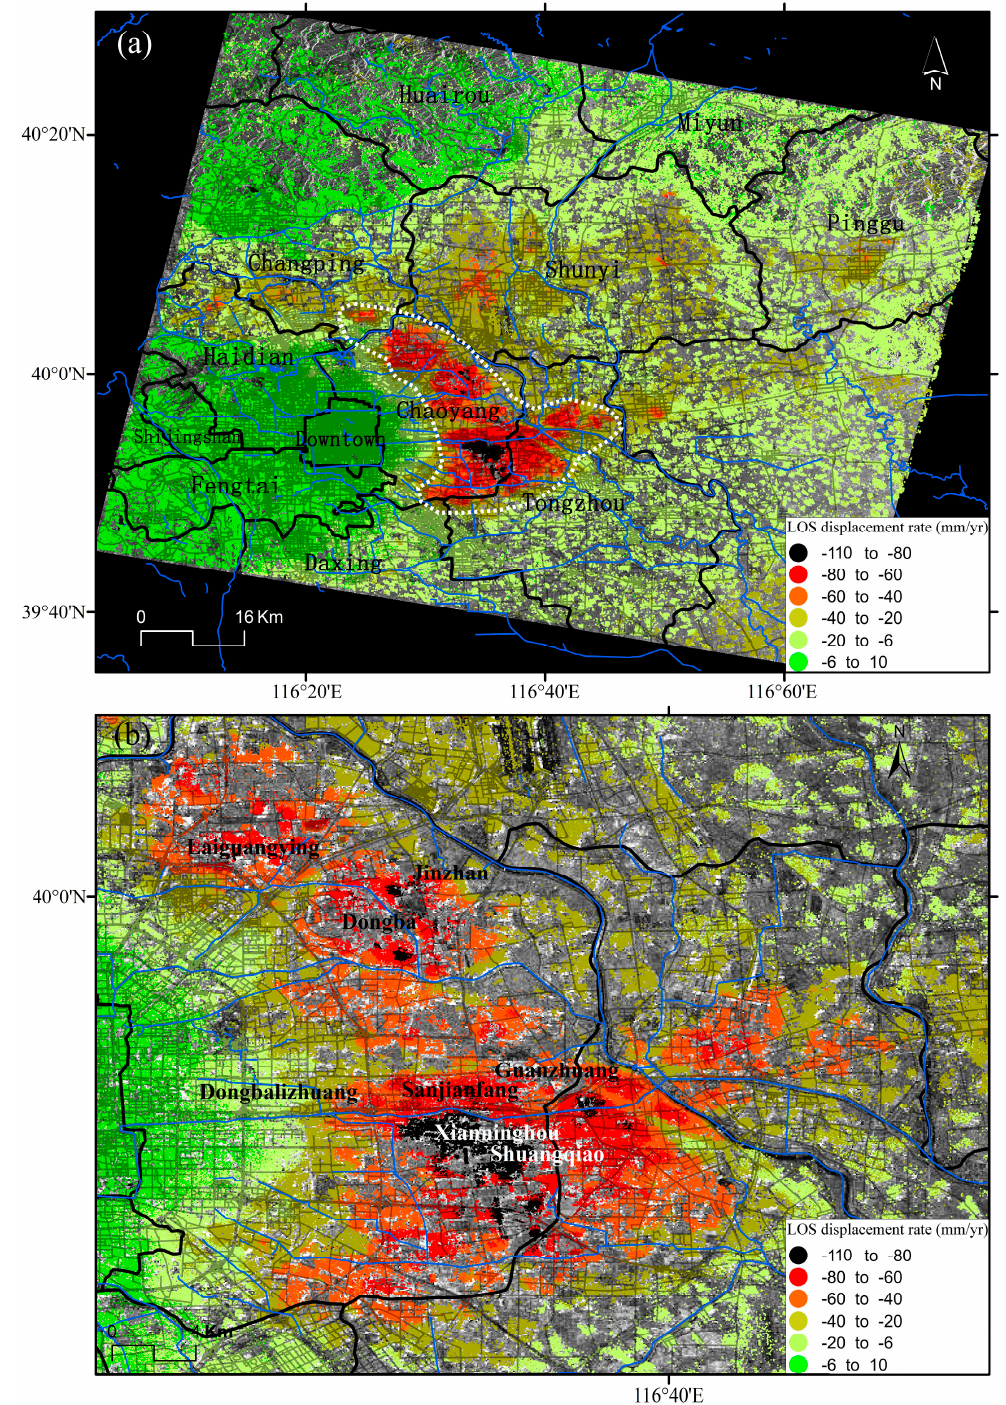
Figure 7. ( a ) Subsidence bowls located in the NE of Beijing; ( b ) extension of the subsidence bowls. Mapped InSAR results along LOS have been derived from Envisat ASAR images acquired from 2003 to 2010.